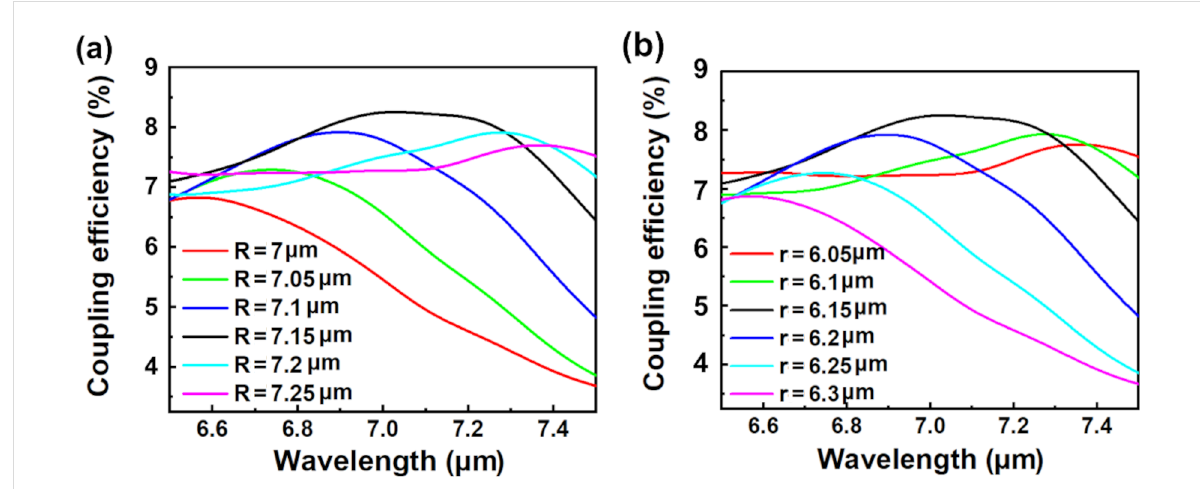
Figure 3: Coupling efficiency of the proposed MIR FGC at different (a) outer radii ( r = 6.15 μ m) and (b) inner radii ( R = 7.15 μ m) with θ = 15°, d = 3.55 μ m, and α = 120°.